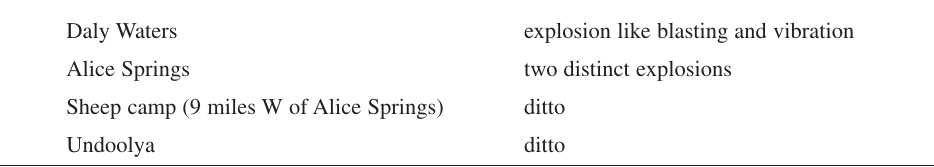
Table II. Earthquake felt reports Northern Territory 27 August 1883, ~10 am local